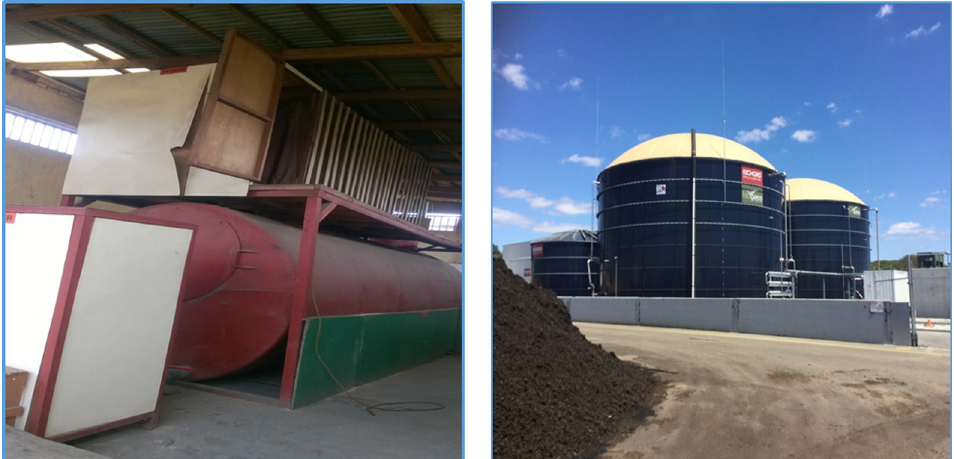
Fig. 3. Pilot anaerobic digester, Ikosi, Nigeria (left), and anaerobic digester, Biogass Renewables Pty Ltd., Perth, Australia (right).